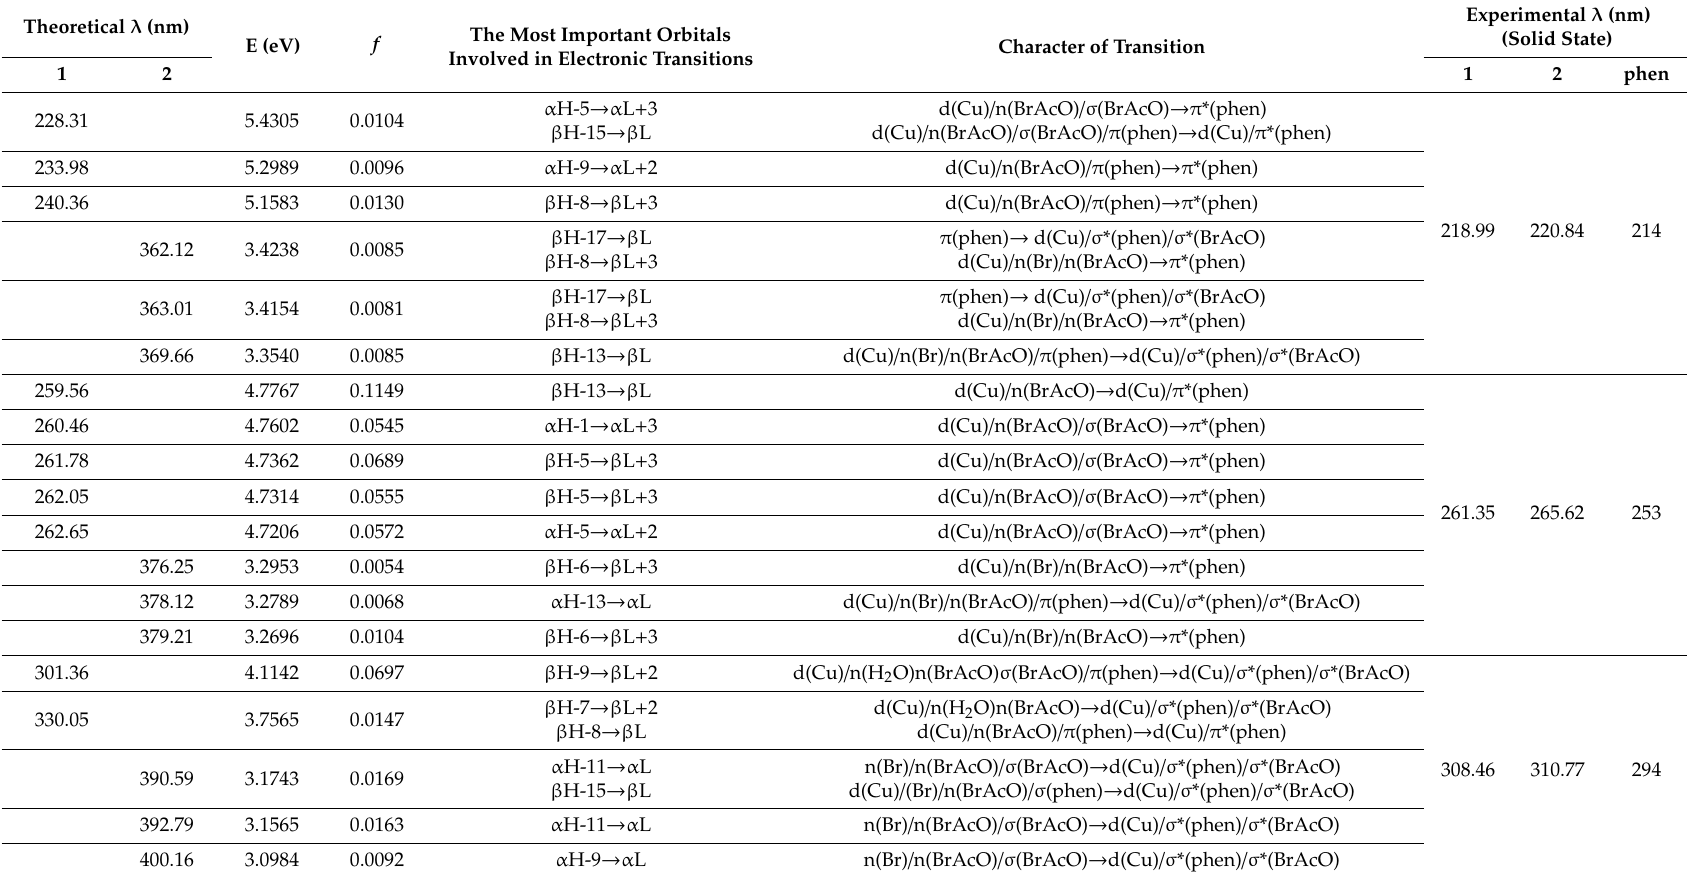
Table 2. The most important electronic transitions. H letter indicate HOMO, L-LUMO, α - α orbitals, β - β orbitals, and ± (number) represents subsequent orbitals above HOMO and LUMO,